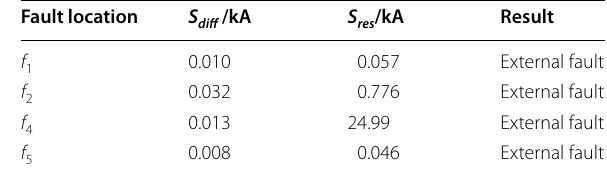
Table 1 Simulation results of N external faults